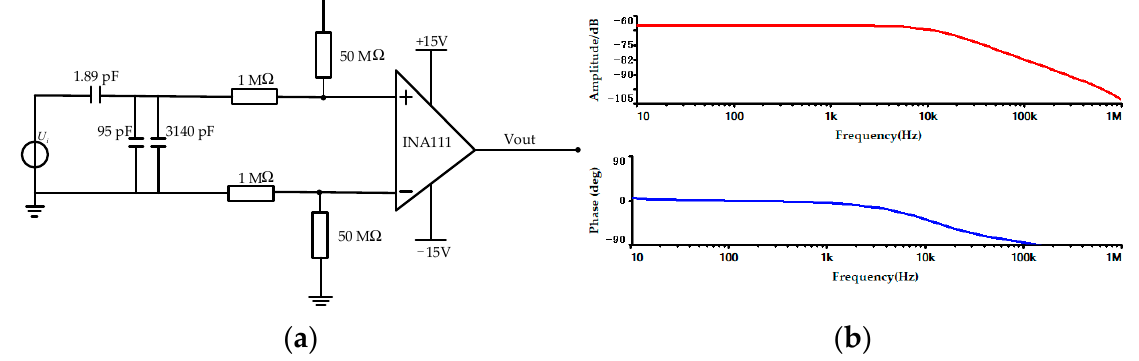
Figure 19. Measurement system equivalent model: ( a ) sensor measurement system equivalent circuit; ( b ) frequency response curve.